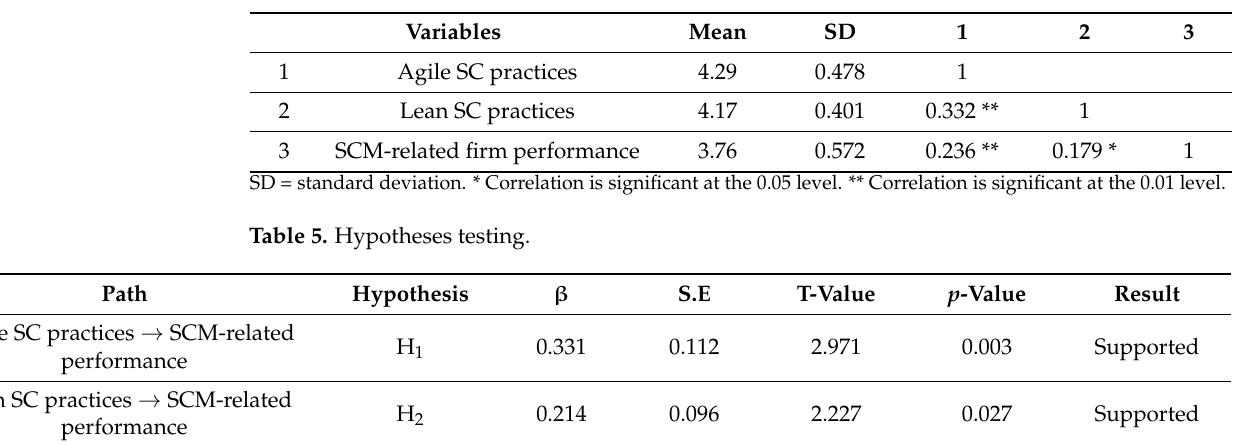
Table 4. Descriptive and correlation analysis.